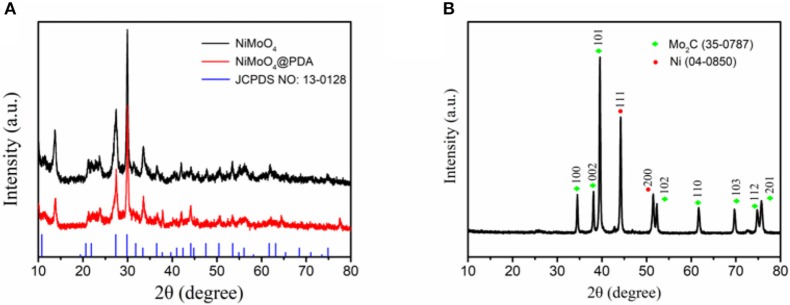
XRD patterns of (A) NiMoO4 and NiMoO4@PDA, and (B) Ni/Mo2C-C.